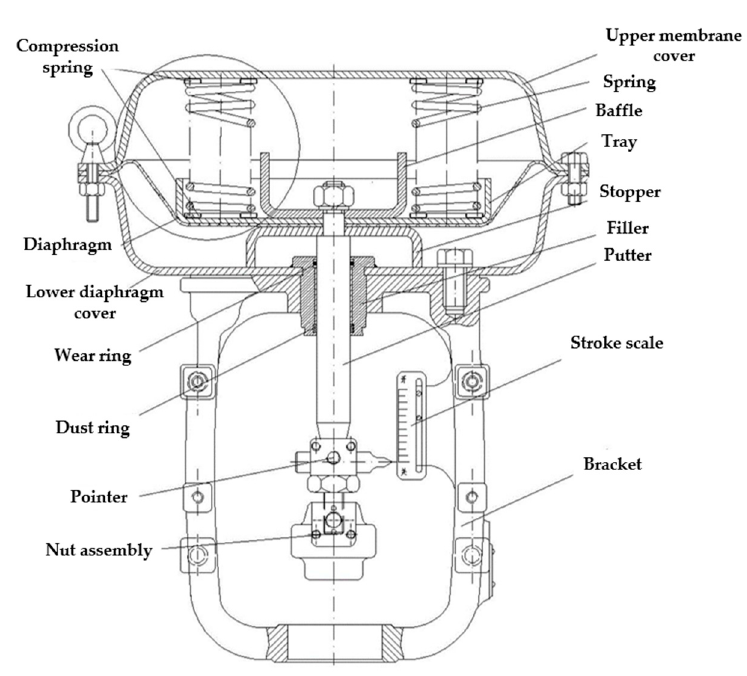
Figure 3. Structural diagram of the valve actuator.